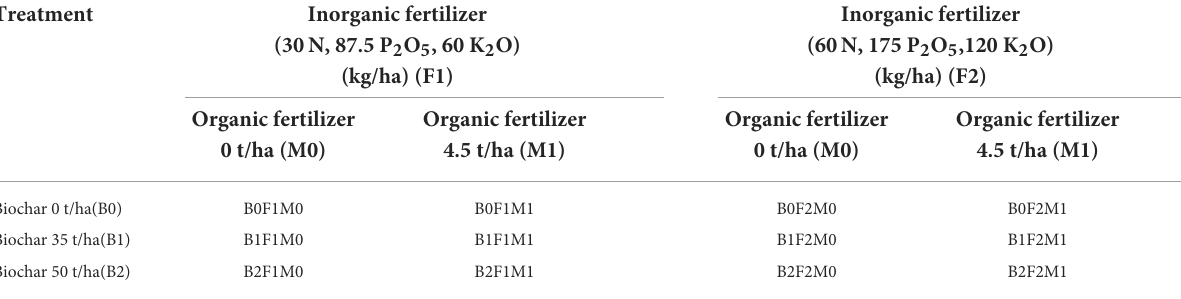
TABLE 1 Treatment combinations of biochar, inorganic fertilizer, and organic fertilizer. Treatment